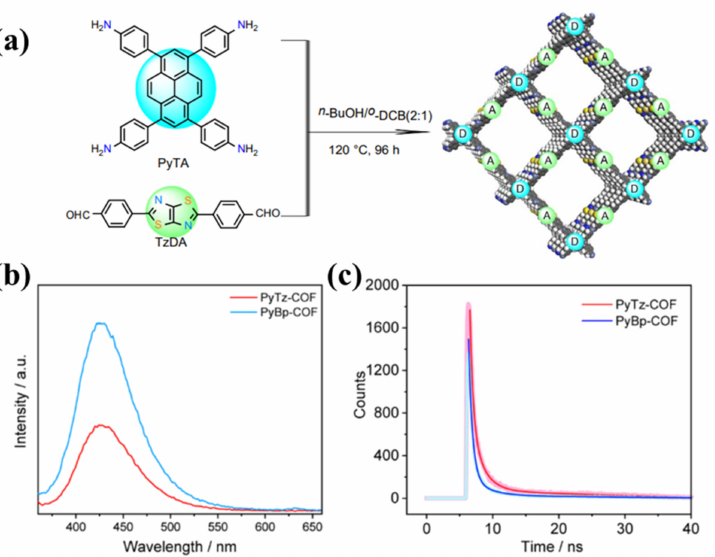
Figure 4. ( a ) Synthetic route and top view of the PyTz-COF. ( b ) PL spectra of PyTz-COF and PyBp-COF (excitation at 320 nm). ( c ) TRPL spectra of PyTz-COF and PyBp-COF (excitation at 320 nm). Reproduced with permission from Ref. [43]. Copyright: Angewandte Chemie International Edition, 2020.